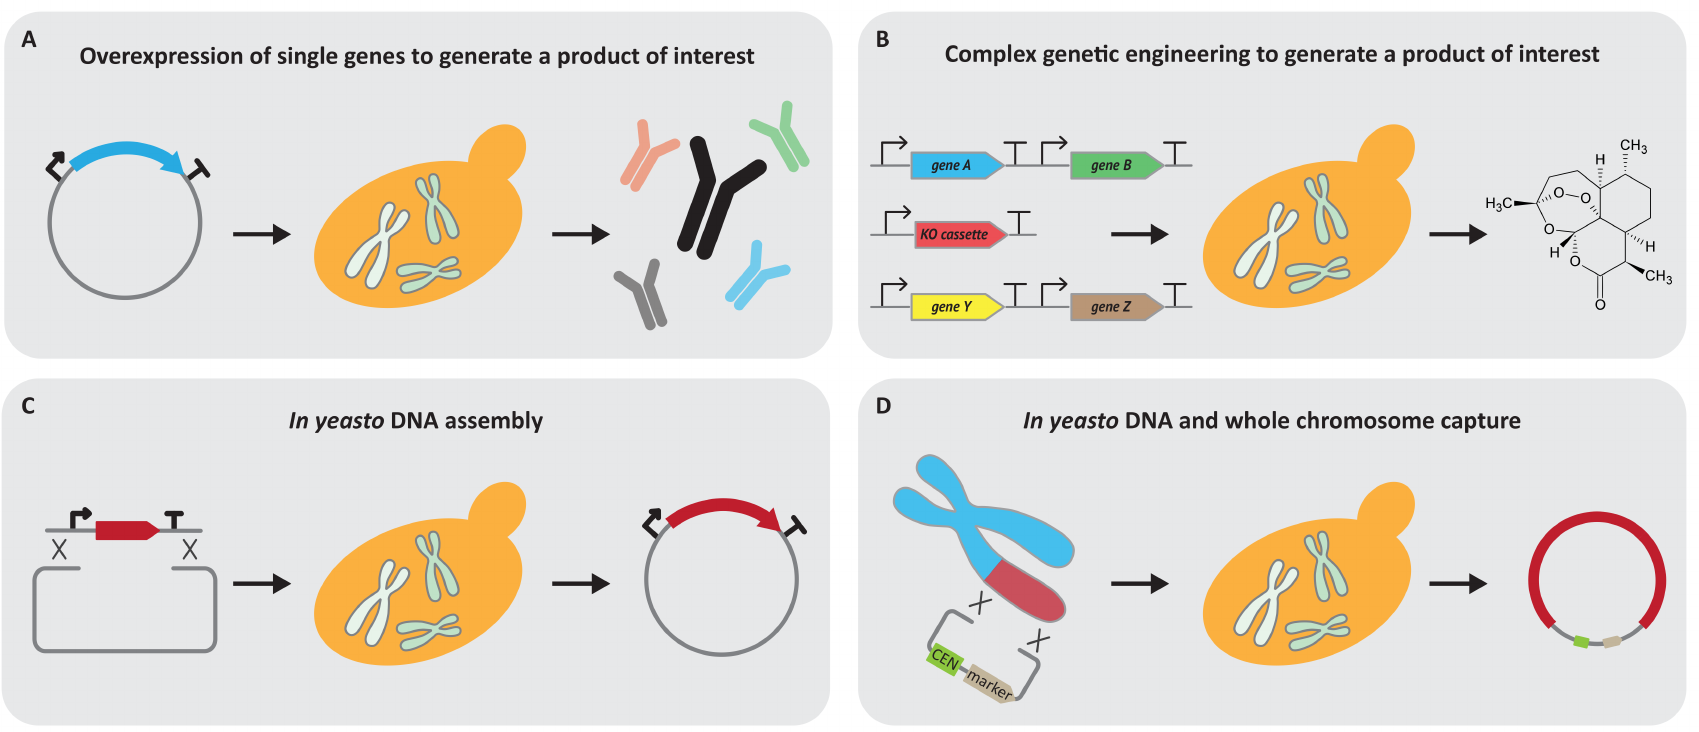
Figure 1. Established yeast 1.0 applications. ( A ) Yeast has been widely used to overexpress single genes which result in a specific product which can be either a protein or a valuable substance. ( B ) The field of genetic engineering quickly evolved and allows complex genetic modifications including, but not limited to, the introduction and / or deletion of genes to optimise yeast as a cell factory for the intended purpose. ( C ) Yeast also has established itself as a DNA assembly host. In yeasto cloning has been used to construct individual plasmids and even whole chromosomes. ( D ) The genome plasticity and ability of DNA uptake of yeast are remarkable, and allow the yeast to capture large DNA fragments up to whole chromosome size under laboratory conditions. Once this DNA is in yeast, it can be modified with the extensive genetic engineering toolbox of